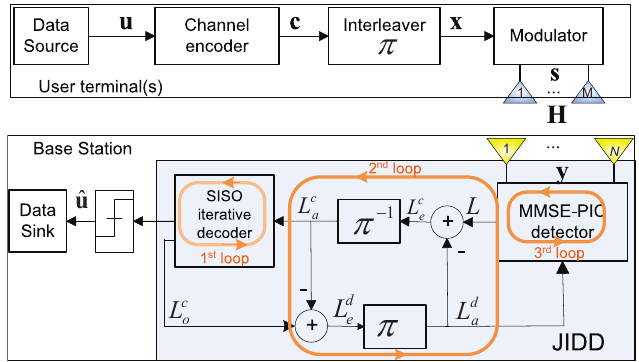
Figure 1. Coded multiple-input multiple-output (MIMO) system with minimum mean square